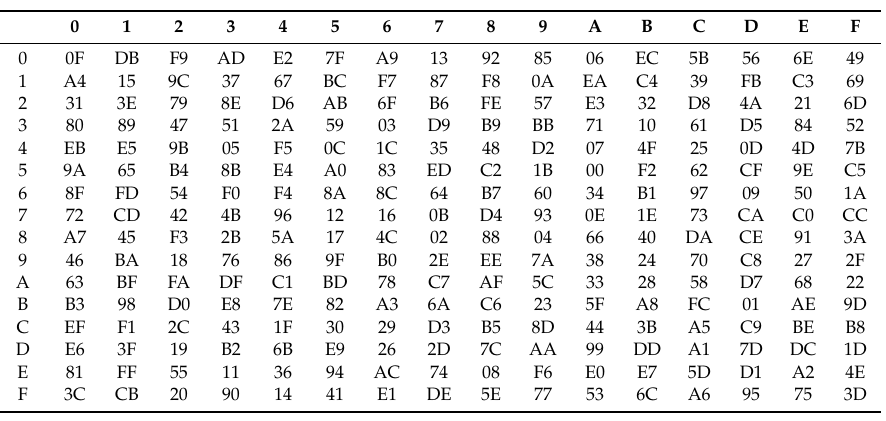
Table 2. Key and plaintext dependent S-Box enforced by RC4 (Key Scheduling Algorithm (KSA) and